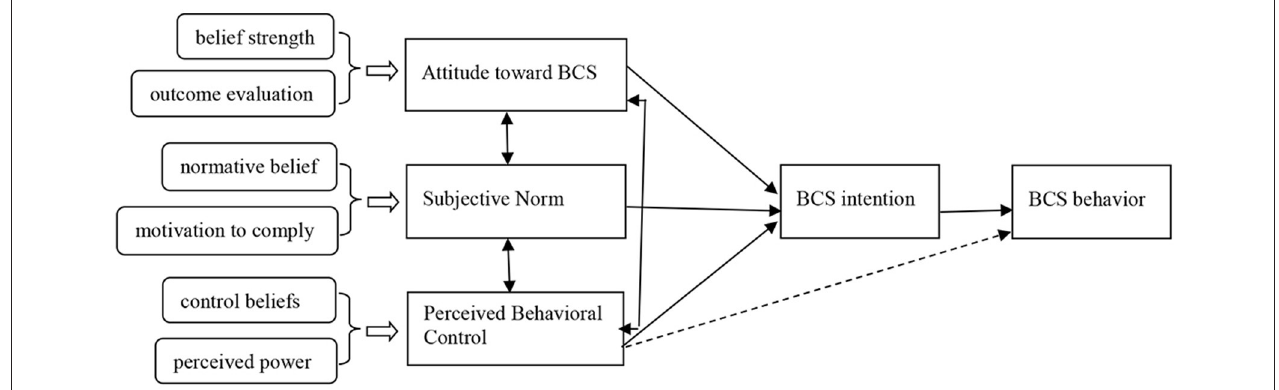
FIGURE 1 | A structural model of the theory of planned behavior (31).